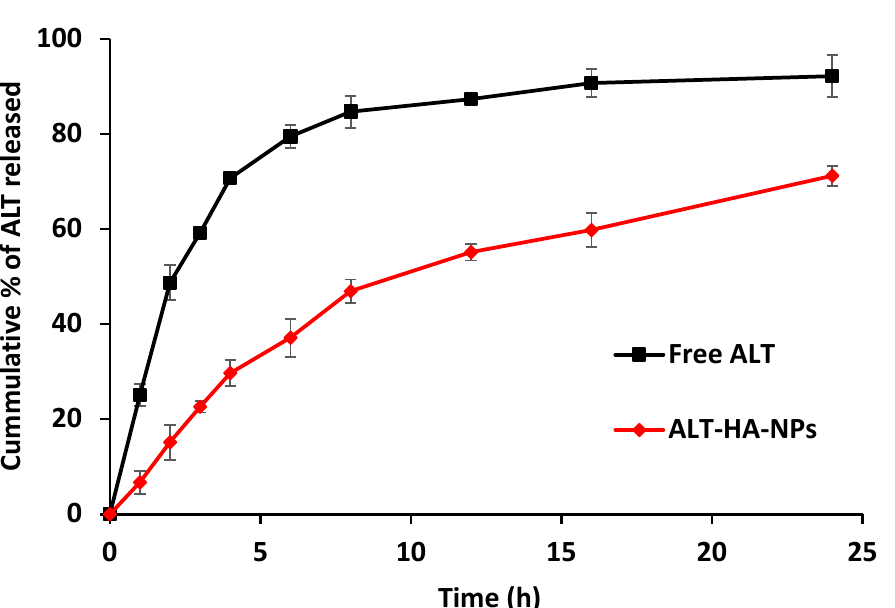
Figure 2. Cumulative percentage of ALT released from pure ALT and the ALT-HA-NPs (n = 3, mean ± SD).